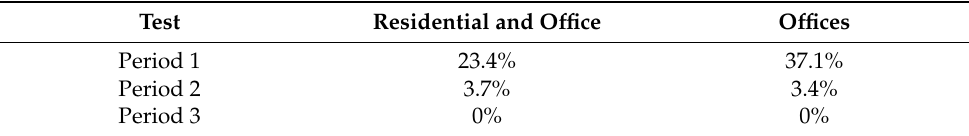
Table 5. Self-consumption